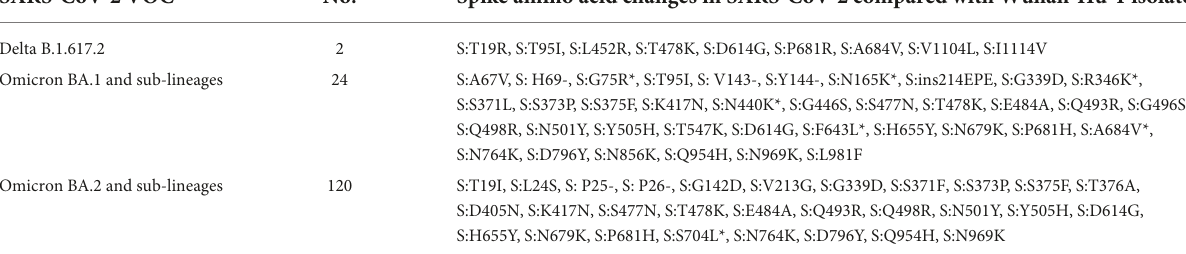
TABLE 2 Residue substitution in spike protein among various lineages of SARS-CoV-2 virus. SARS-CoV-2 VOC No. Spike amino acid changes in SARS-CoV-2 compared with Wuhan-Hu-1 isolate Delta